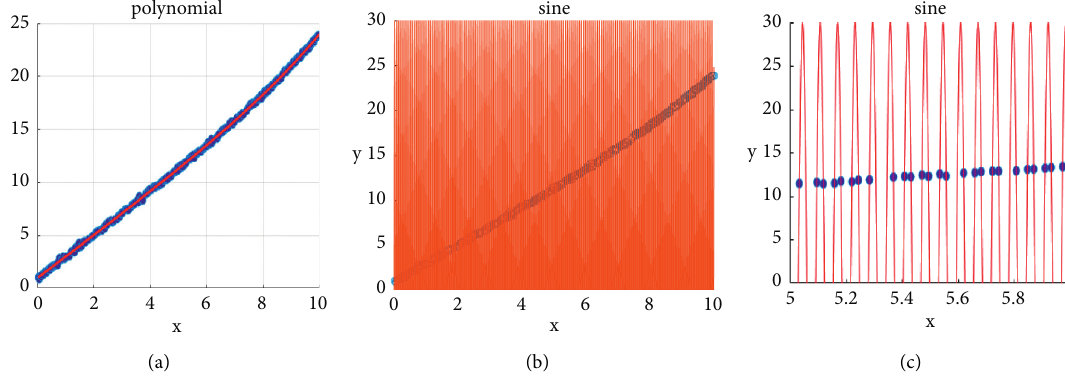
Figure 1: (a) Data generated by a fifth-order polynomial. (b) Fit with a high frequency sinusoidal function. (c) Zoom of the plot in the centre to show the quality of the fit of the